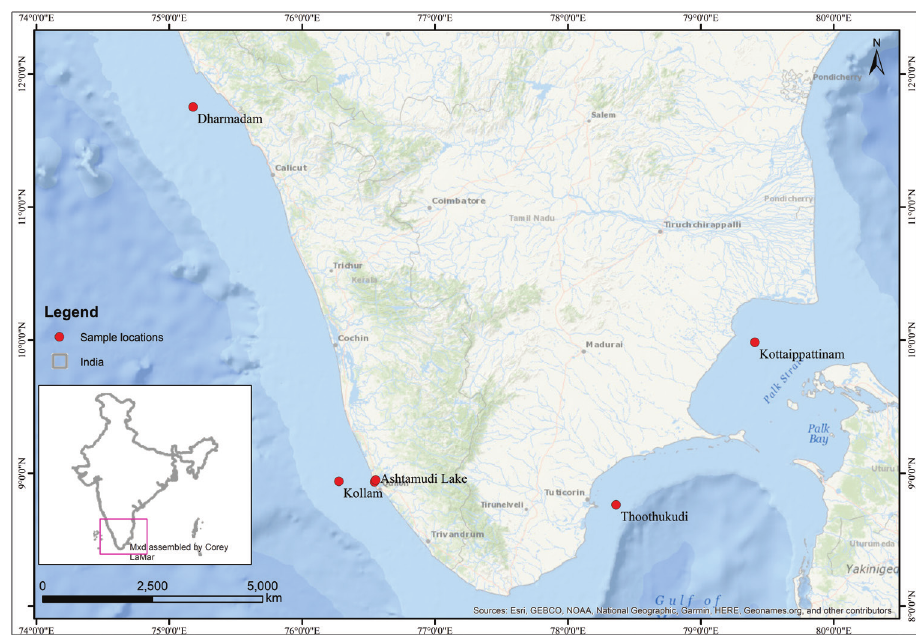
Figure 1. Sampling locations of venerid clams from the coast of southern